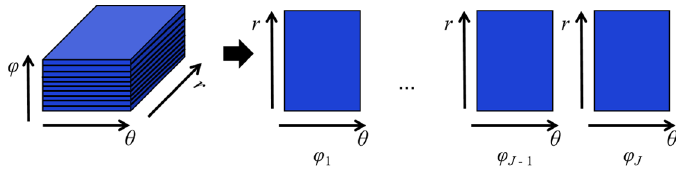
Figure 6. Unmanned vehicle platform with light detection and ranging (LiDAR).